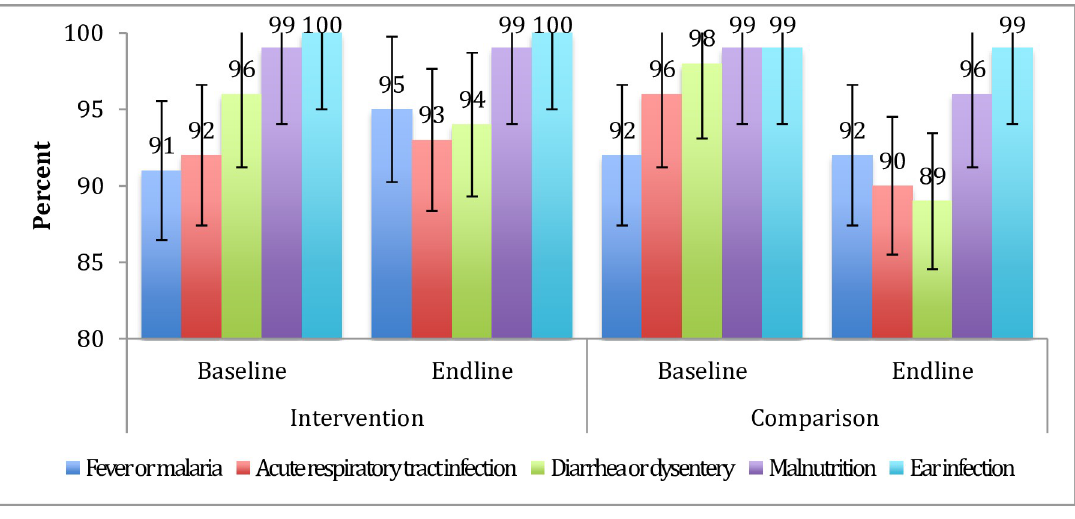
PLOS ONE | https://doi.org/10.1371/journal.pone.0247474 March 12,